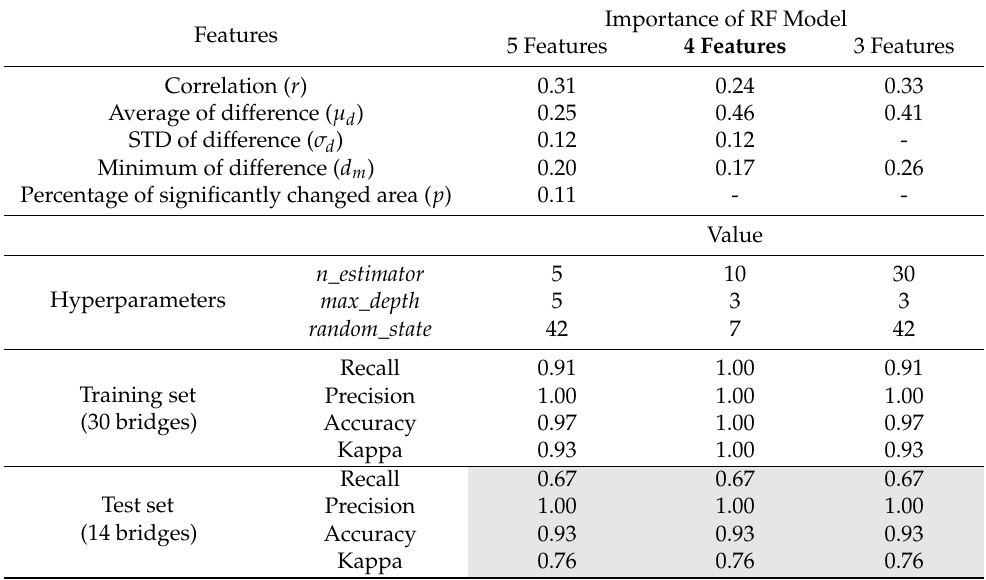
Table 4. Comparison of the RF models using data set 1 with different numbers of features, where the best model is emphasized in bold font. The highest accuracy for the test data is emphasized by the gray